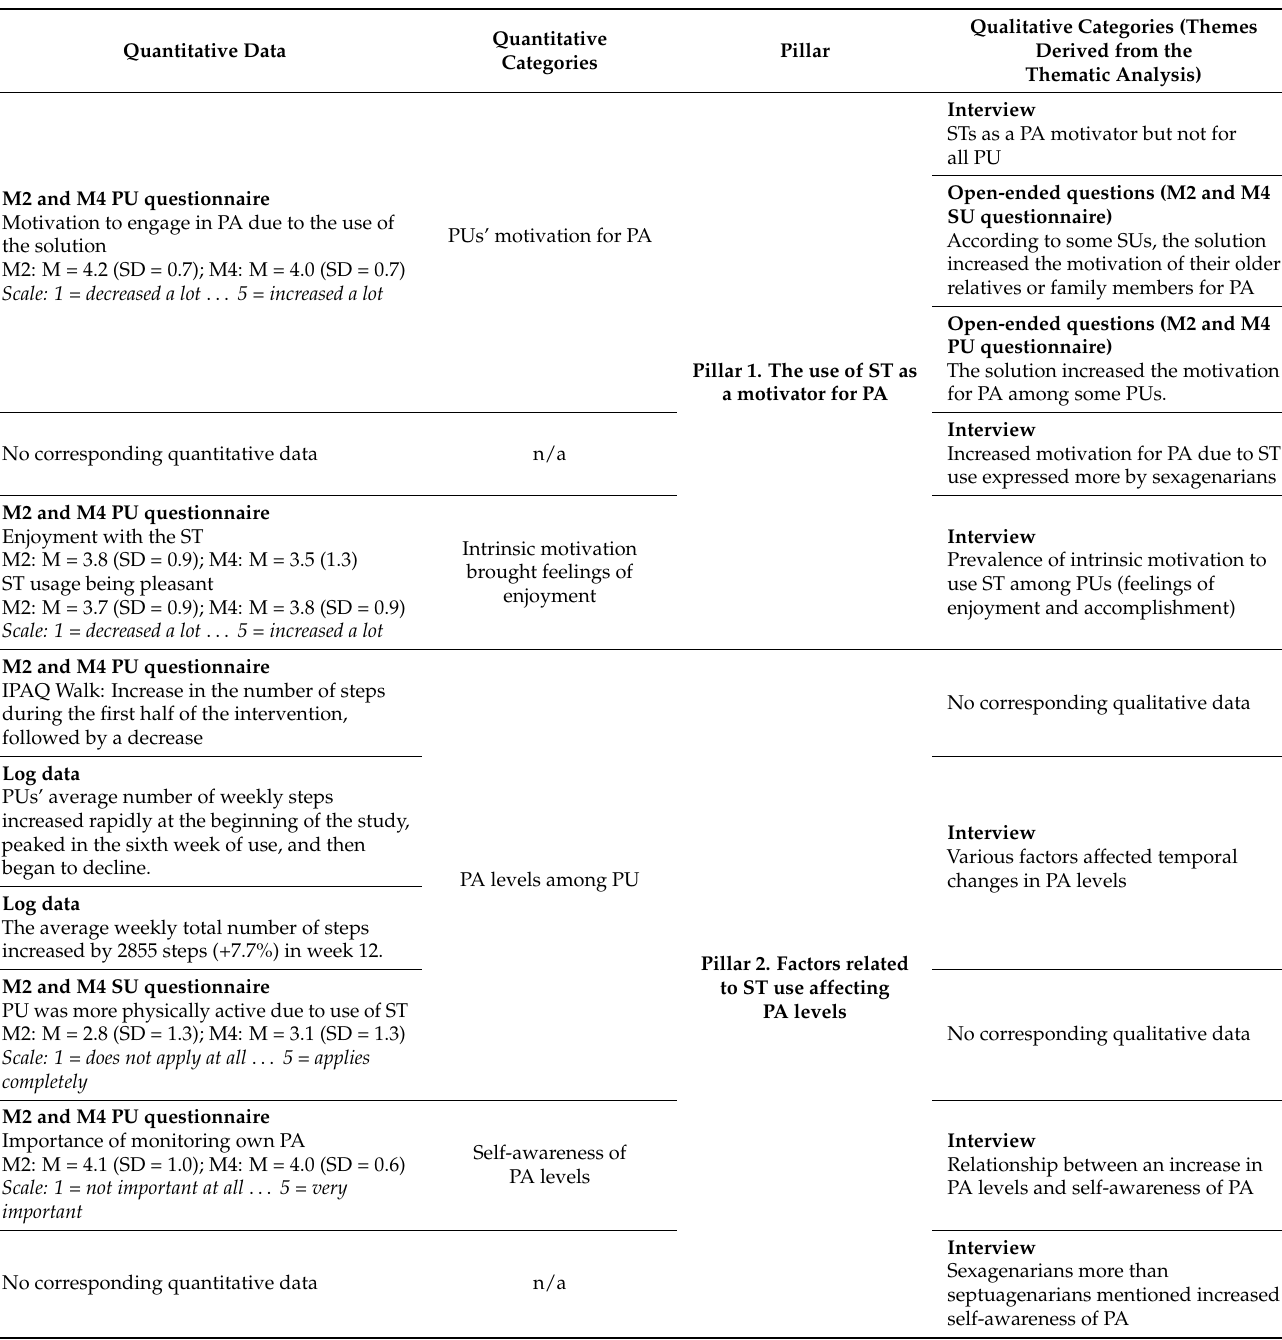
Table 3. A joint display of the connections between the quantitative and qualitative data arising from the study—Pillars 1 and